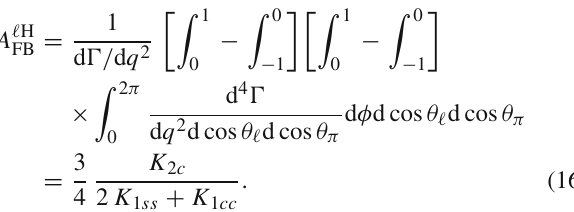
Fig. 1 The hadronic forward–backward asymmetry A H plot) for (cid:2) + c → (cid:3) + ( → p π 0 )μ + μ − decays in the SM (orange) and in NP scenarios with C 7 = 0 . 3, C (cid:3) red and green, respectively. A NP scenario with C 9 or C 10 only is not shown, as it is indistinguishable from the SM. The right plot shows the